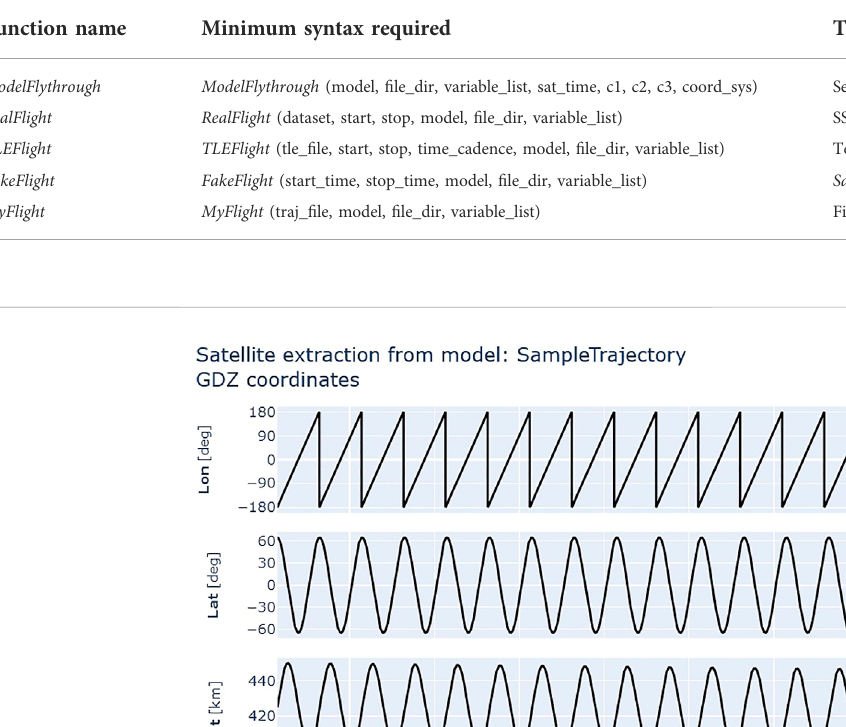
TABLE 1 Flythrough Functions. The function names are followed by the minimum syntax required for each of the four fl ythrough functions. The source of each of the trajectories is indicated in the last column. SatelliteTrajectory, TLETrajectory , and SampleTrajectory are functions available through the fl ythrough software. See text for a basic description of each, and the example notebooks and documentation for more information 8 .